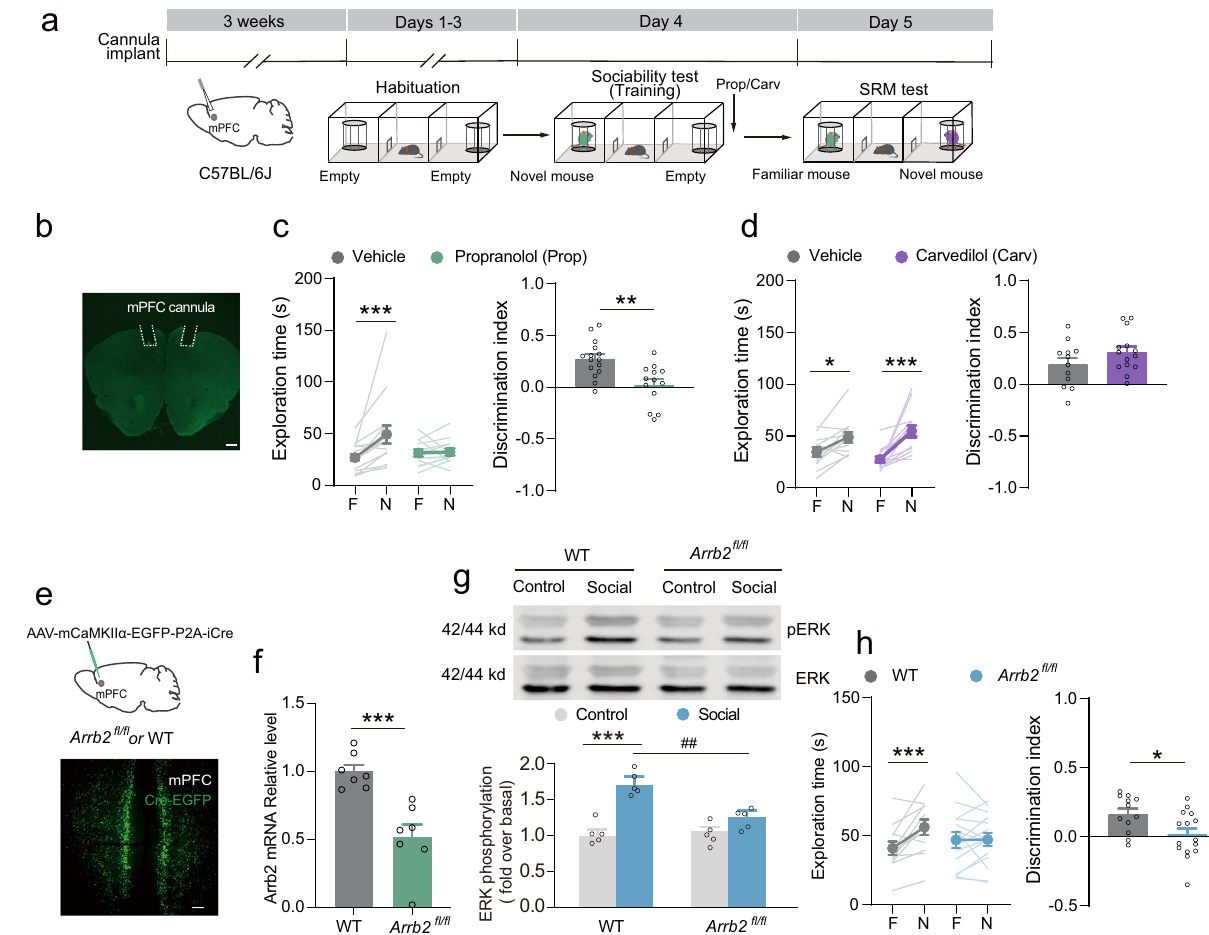
Fig. 3 β -AR/ β -arrestin2 signaling in the mPFC mediate SRM consolidation. a Experimental scheme. β -AR antagonist, propranolol (10 μ g), or carvedilol (5 μ g) was infused right after training and SRM tests were carried out 1 day later. b Representative image of cannula implantation in the mPFC. Scale bar: 500 μ m. c , d Statistical graphs of exploration time for the familiar (F) and novel (N) mice and discrimination scores [ c , Vehicle: n = 15, Propranolol: n = 13. Left: F mouse × treatment (1, 26) = 6.906, p = 0.014, two-way RM ANOVA; Right: t (26) = 3.507, p = 0.002, two-tailed Student ’ s t test. d Vehicle: n = 12, Carvedilol: n = 14. Left: F mouse × treatment (1, 24) = 2.707, p = 0.113, two-way RM ANOVA; Right: t (24) = − 1.477, p = 0.153, two-tailed Student ’ s t test]. e Representative image of Cre-EGFP expression in the mPFC. AAV 9 -mCaMKII α -EGFP-P2A-iCre was injected in the mPFC of Arrb2 fl / fl mice and their WT littermates. Scale bar: 100 μ m. f Bar graph for Arrb2 mRNA relative expression level. 4 weeks after injection AAV 9 -mCaMKII α -EGFP-P2A-iCre into mPFC of Arrb2 fl / fl mice and their WT littermates [ n = 7 for each group, t (12) = 4.515, p < 0.001, two-tailed unpaired t test]. g Representative Western blots and bar graph for pERK levels in the mPFC with β -arrestin2 knockout [ n = 5 for each group. F mouse × session (1, 16) = 11.556, p = 0.004, two-way ANOVA]. h Statistical graphs of exploration time for the familiar (F) and novel (N) mice and discrimination scores. [WT: n = 12, Arrb2 fl / fl : n = 15. Left: F mouse × genotype (1, 25) = 7.094, p = 0.013, two-way RM ANOVA; Right: t (25) = 2.557, p = 0.017, two-tailed unpaired t test]. * p < 0.05, ** p < 0.01, *** p < 0.001 and ## p < 0.01 vs indicated